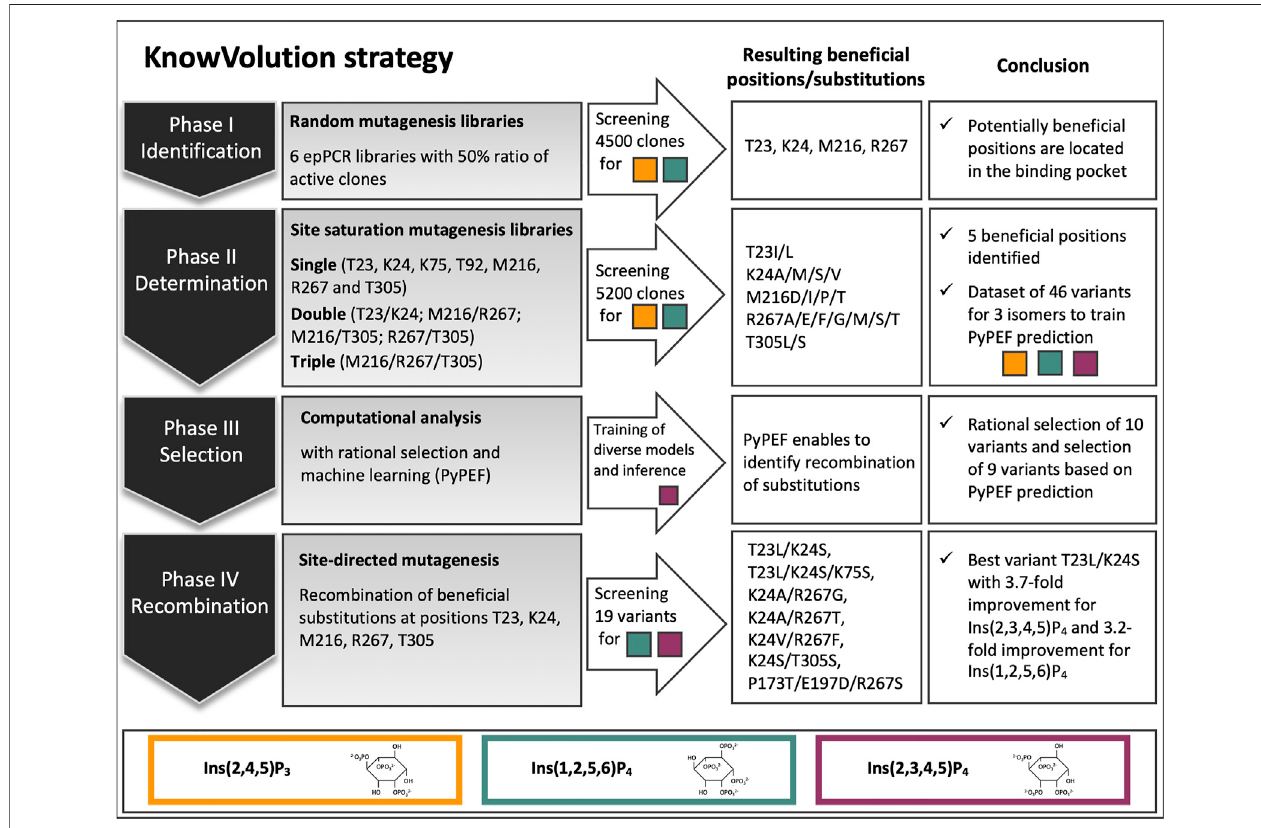
FIGURE1| Overviewoftheknowledge gainingdirectedevolution(KnowVolution)approachof E.coli phytase(Ecphy) towardimproved hydrolysis oflowerinositol phosphates. In phase I: Screening of more than 4,500 clones from error-prone PCR (epPCR) libraries resulted in variants with up to 2.5-fold improved hydrolysis of Ins(1,2,5,6)P 4 and the identi fi cation of potentially bene fi cial positions. In phase II: Determination of bene fi cial substitutions by SSMs was successful. A dataset of 46 variants for enzymatic activity on all three isomers [Ins(2,4,5)P 3 , Ins(2,3,4,5)P 4, and Ins(1,2,5,6)P 4 ] was generated. In phase III: Computational analysis was performed. Machine learning (PyPEF) enabled to predict recombinants. In phase IV: Recombination of bene fi cial substitutions lead to activity improved variants by up to 3.7-fold on the main E. coli isomers [Ins(2,3,4,5)P 3 , Ins(1,2,5,6)P 4 ].